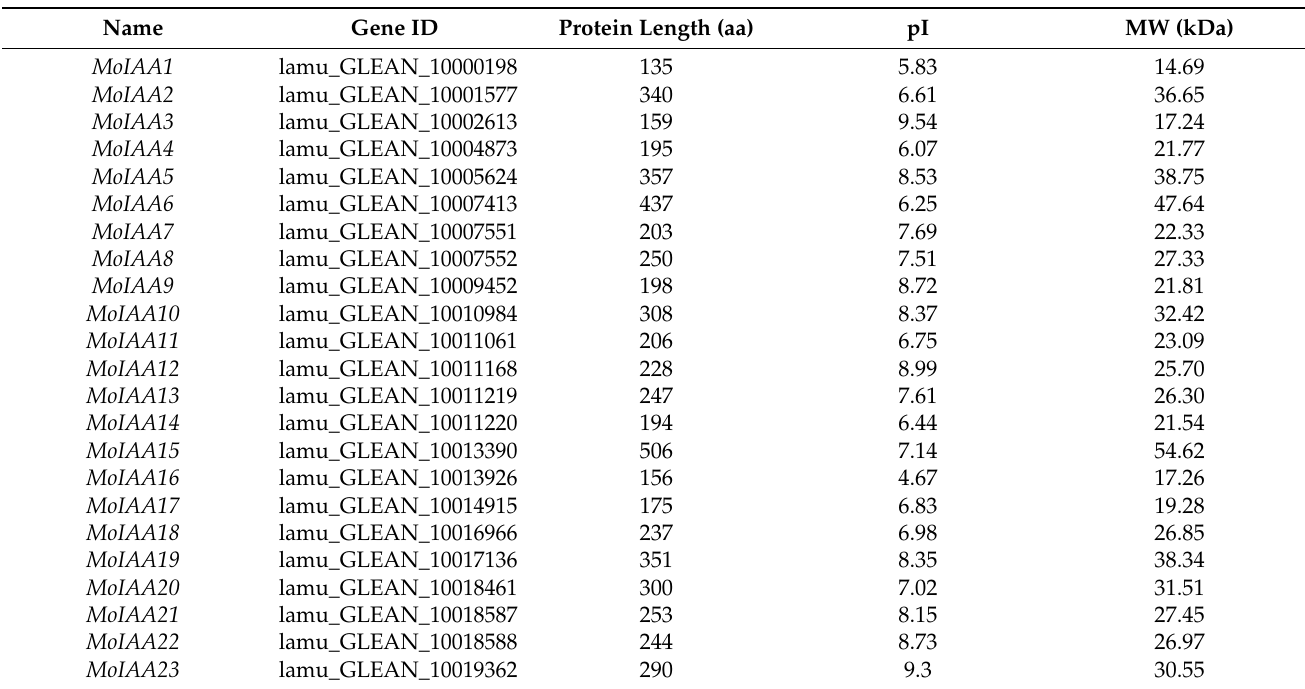
Table 1. Molecular characteristics of MoIAA genes in M. oleifera